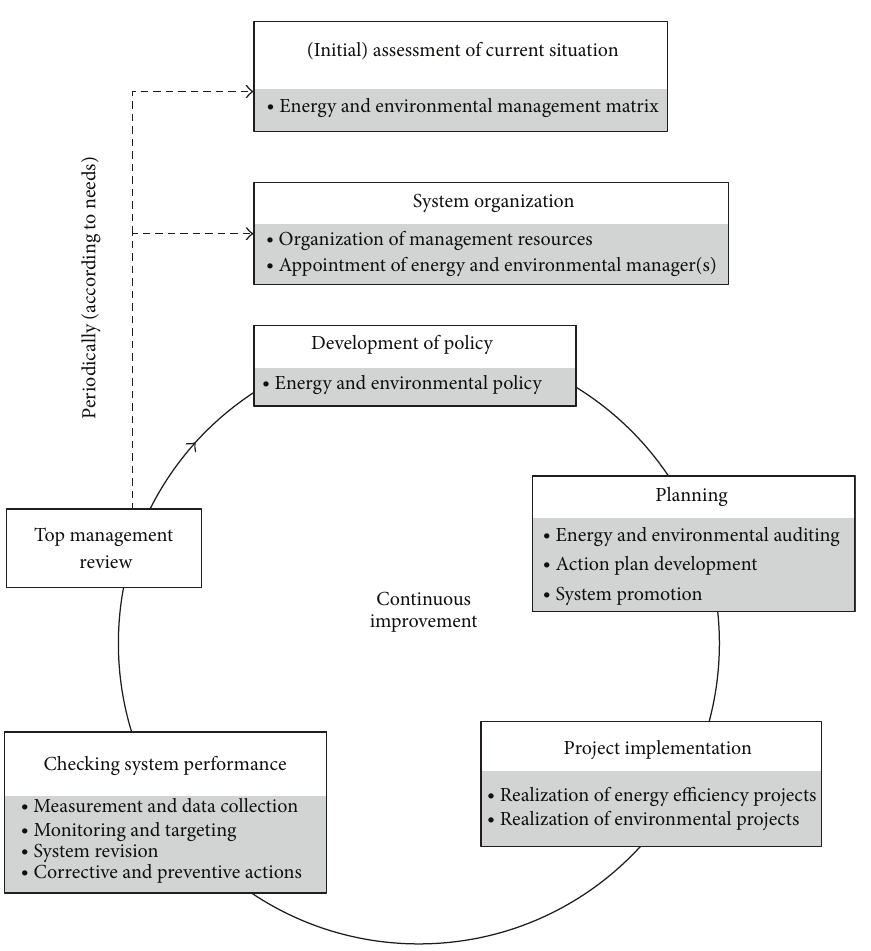
Figure 1: Structure of energy and environmental management system